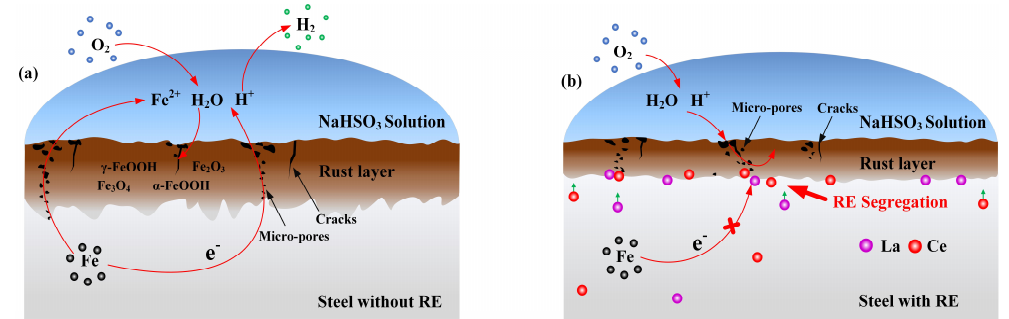
Figure 8. Schematic of RE atom layer preventing from corrosion ( a ) before RE alloying ( b ) after RE alloying.